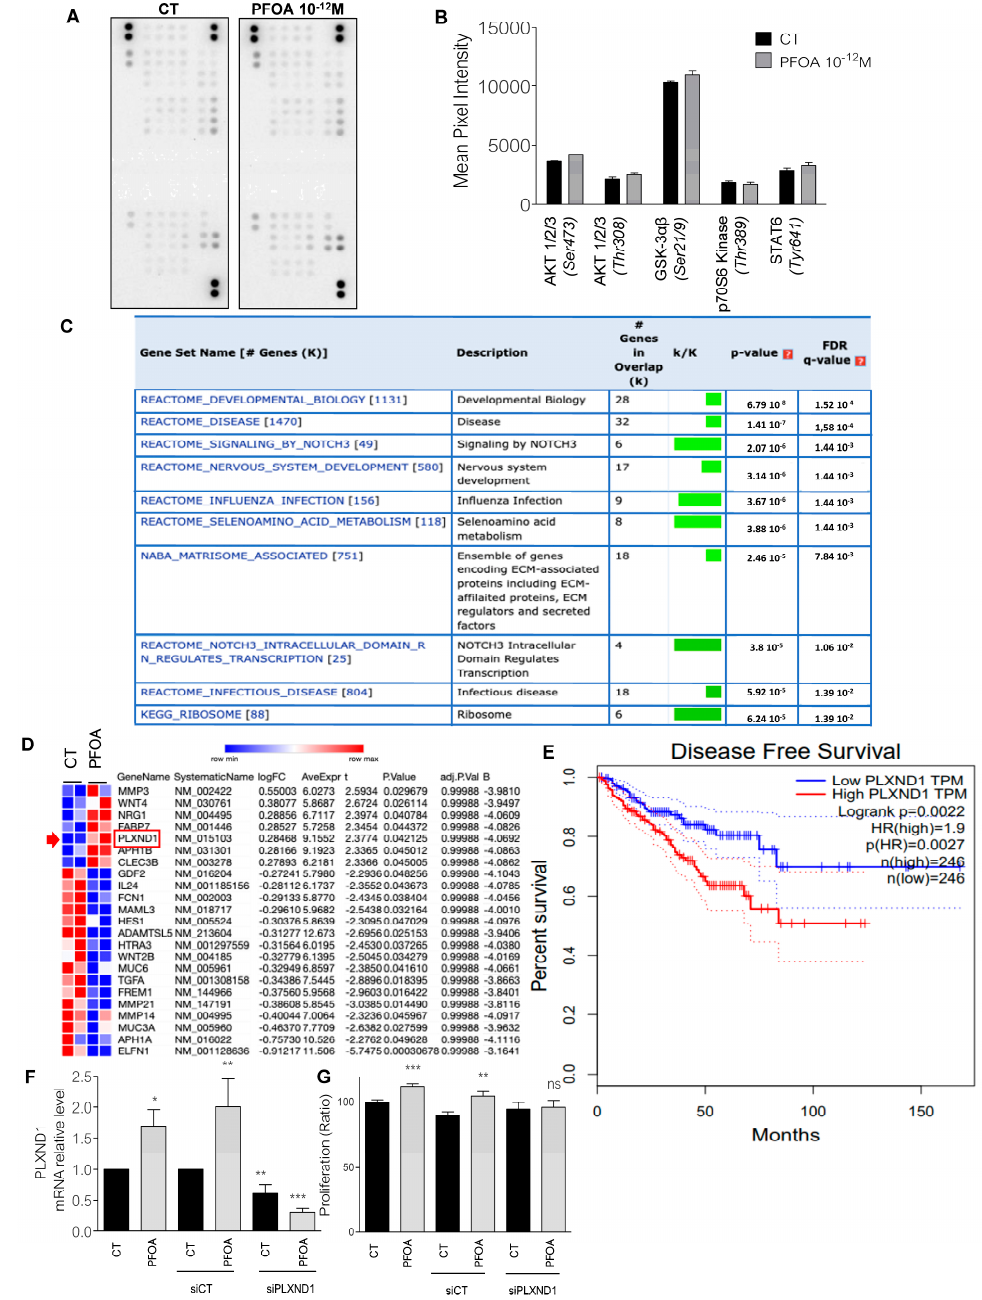
Figure 3. Plexin D1 plays an important role in PFOA-induced proliferation in DU145 cells. ( A , B ) Image and quantification of Human Phospho-Kinase Array. Relative levels of protein phos- phorylation of a range of 43 kinase phosphorylation sites of DU145 cells after 48 h of treatment with PFOA (10 − 12 M) in comparison with cells exposed with EtOH (CT). ( C ) Top ten gene sets of enrichment analysis from a microarray performed on RNA from cells treated 48 h with 10 − 12 M PFOA. ( D ) Heatmap analysis of genes modified by the treatment with PFOA (10 − 12 M) belonging to Notch3 and matrisome gene sets. ( E ) Disease free survival related to PlexinD1 expression in prostate cancer patients of the TCGA database. ( F ) Expression of PLXND1 mRNA in DU145 cells treated 48 h with 10 − 12 M PFOA. Cells were transfected with siRNA Control (siCT) or siRNA PLXND1. ( G ) Pro- liferation assay (BrdU incorporation) performed in DU145 cells treated 48 h with 10 − 12 M PFOA, transfected with siCT or siPLXND1. T test. * p < 0.05; ** p < 0.005; *** p < 0.0005; ns: